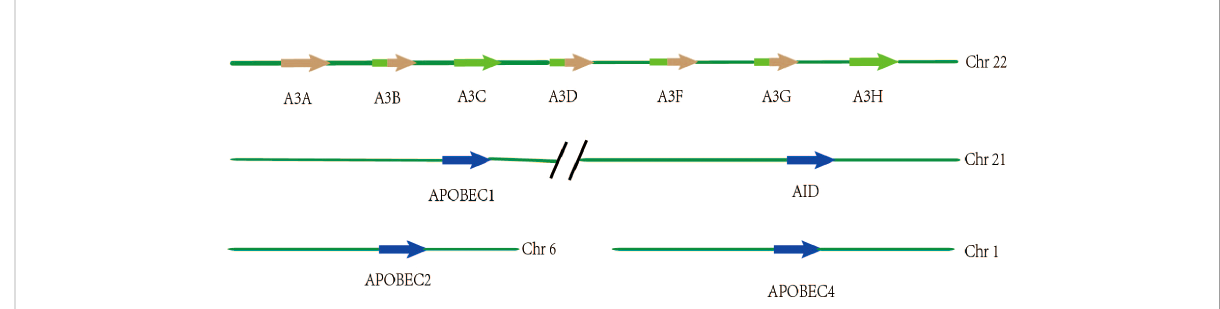
FIGURE 1 Spatial location distribution of genes among members of the APOBEC3 family. The seven members of APOBEC3 are arranged in tandem on chromosome 22, of which APOBEC3B, APOBEC3D, APOBEC3F, and APOBEC3G have two zinc catalytic enzyme structures, while the others have only one. APOBEC1 and AID are connected in tandem on chromosome 21, respectively. APOBEC2 and APOBEC4 are present on chromosome 6 and chromosome 1,